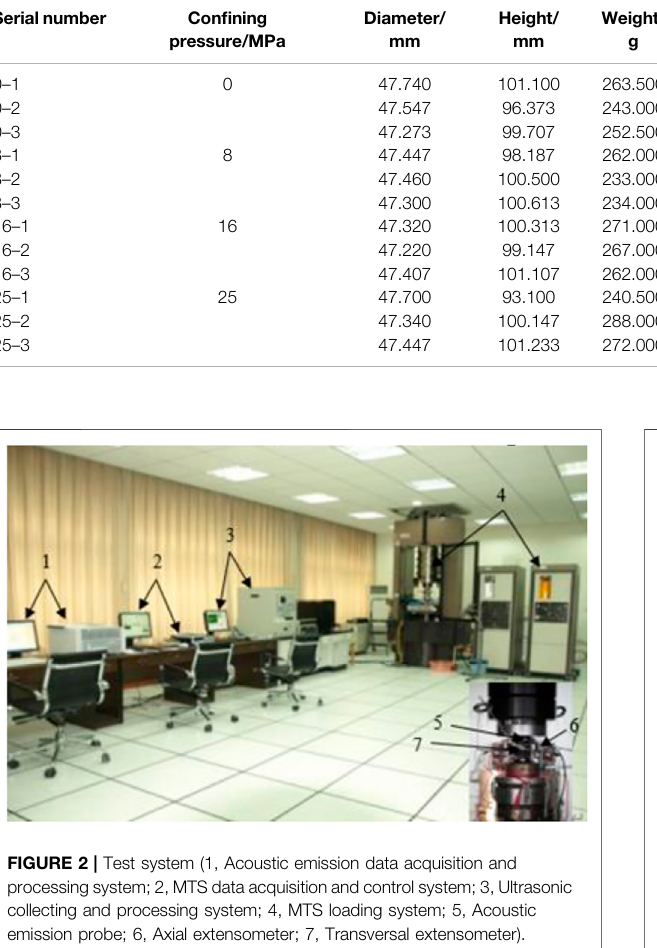
TABLE 2 | Basic characteristics of coal rock samples.